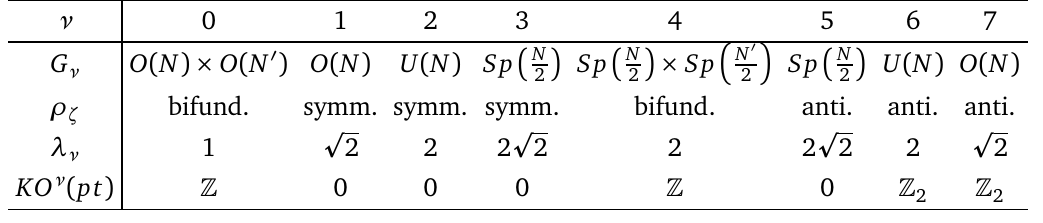
Table 5: Gauge groups G ν and tachyon representations ρ ζ on the worldvolume of N ( 9 − k ) -branes of type η in the theory with n copies of ABK. Note